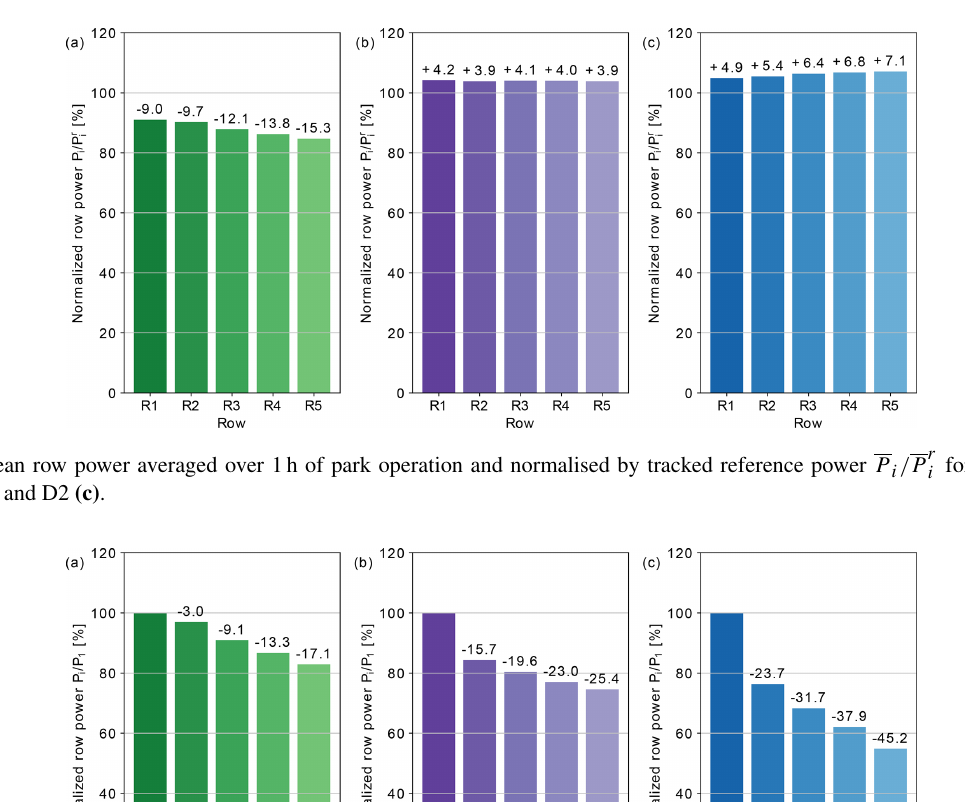
Figure 21. Mean row power averaged over 1h of park operation and normalised by front row value P i /P 1 for the AWE parks L1 (a) , D1 (b) , and D2 (c)